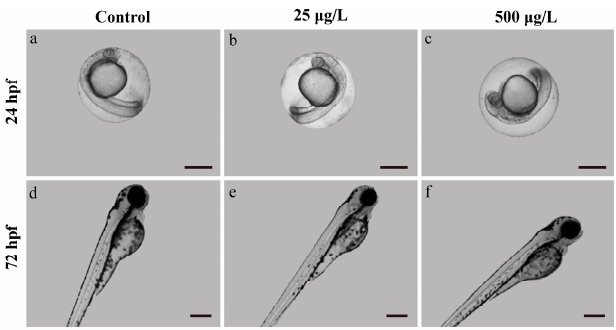
Figure 2. Representative morphological photographs of zebrafish exposed to methamidophos at 24 and 72 hpf. Scale bars: 500 μ m ( a – c ) and 250 μ m ( d – f ).